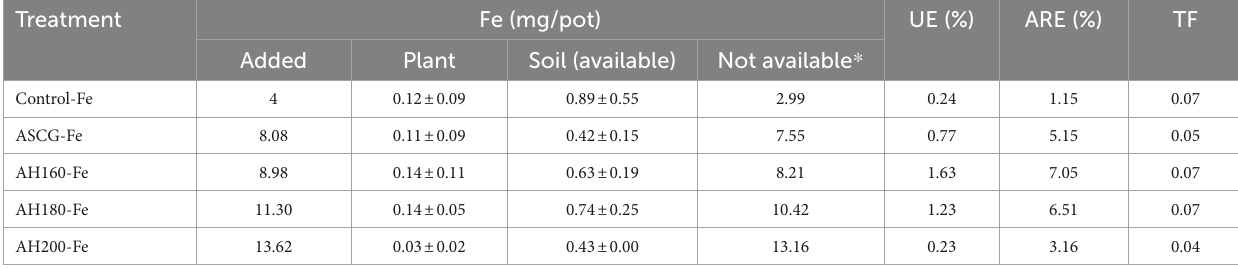
TABLE 3 Fe balance and efficiency evaluation parameters in the plant–soil system.